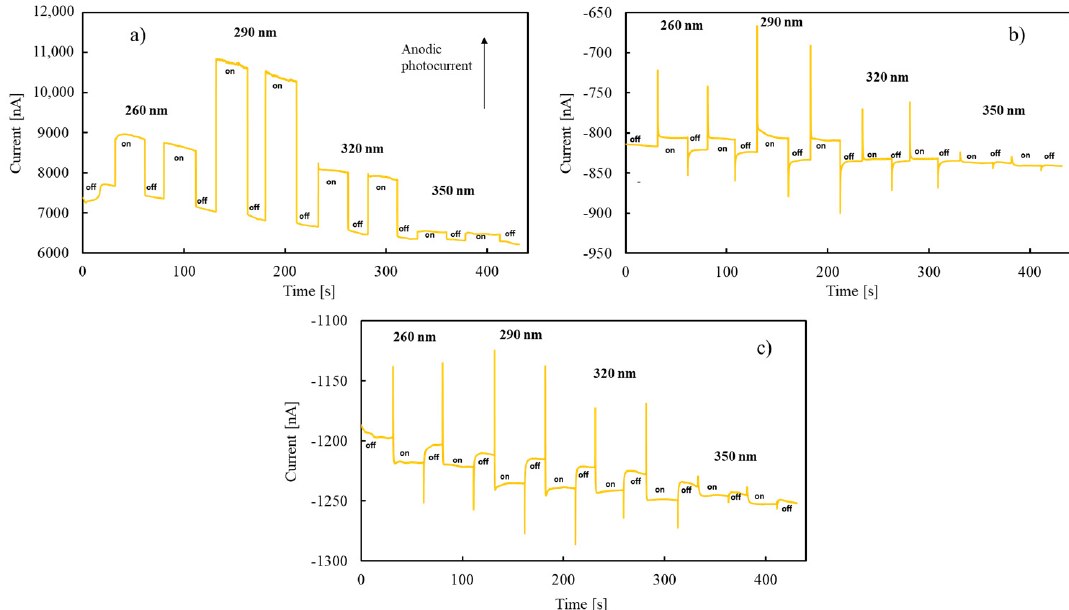
Figure 4. Total current circulating without irradiation (off) and with irradiation (on) in the oxide grown on Ta-85at%Nb to 50 V at λ = 260, 290, 320 and 350 nm by polarizing the electrode at ( a ) 8 V, ( b ) − 0.4 V and ( c ) − 0.5 V vs. Ag/AgCl.